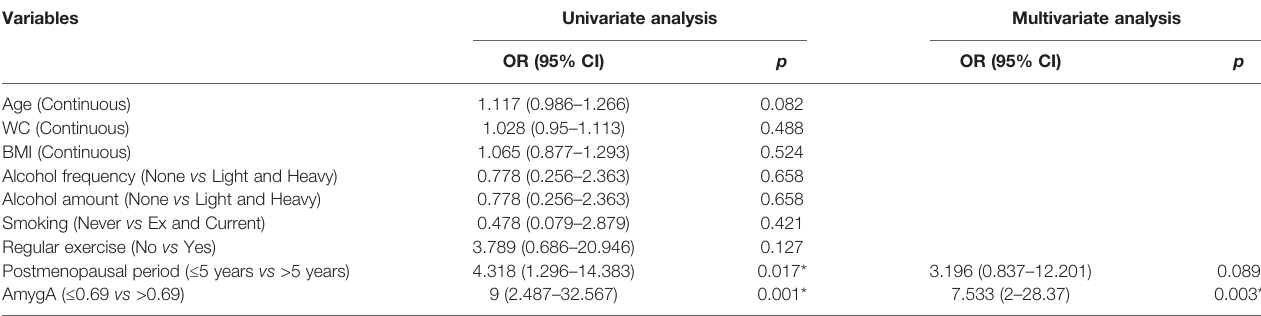
OR, odds ratio; CI, con fi dence interval; WC, waist circumference; BMI, body mass index; AmygA, the metabolic activity of amygdala. *Statistically signi fi cant